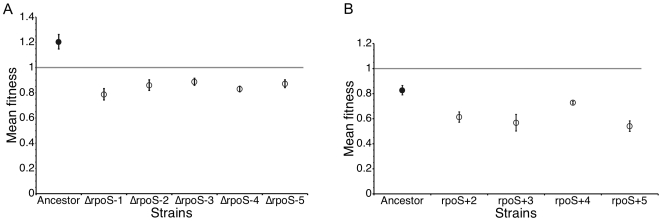
Adaptation was contingent on the status of rpoS.A functional rpoS allele was transferred into each of the five ΔrpoS lines, and each of ΔrpoS strains was competed against this newly rpoS+ strain (A). In the wild-type background, strains with rpoS+ are more fit than ΔrpoS (filled circle), indicated by fitness greater than 1. All five evolved backgrounds are less fit as rpoS+ than ΔrpoS (open circles), as indicated by fitness less than 1. The dashed line shows fitness of 1, indicating equal fitness between the two competitors. A ΔrpoS line was derived from the rpoS+ lines, and each of these pairs of strains was competed (B). While ΔrpoS is less fit on the wild-type background (filled circle), ΔrpoS is even more detrimental for lines rpoS+2, rpoS+3, and rpoS+5 (open circles). Line rpoS+1 evolved resistance to P1, so the transduction could not be performed.